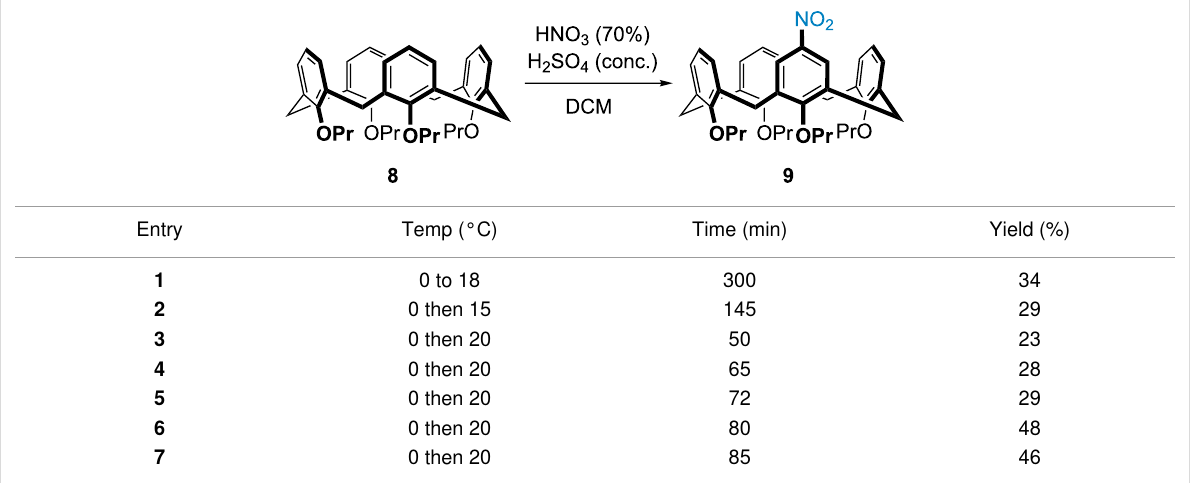
Table 1: Optimization results for the mononitration of calix[4]arene 9